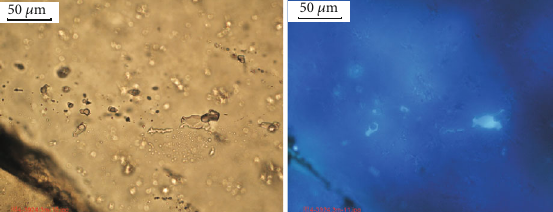
(d) Transparent colorless-gray gas-liquid hydrocarbon inclusion (condensate) with blue-green fl uorescence, 3116.5m, Xi-I Member (Xishanyao Formation), well Ke24; the left is under the plane-polarized light, and the right is under the UV-light